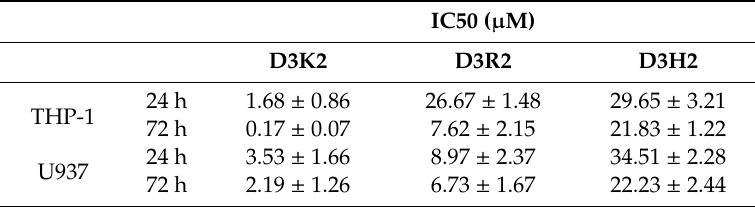
Table 2. Cytotoxicity of PLL dendrimers (IC50 values, average ± SD, n =